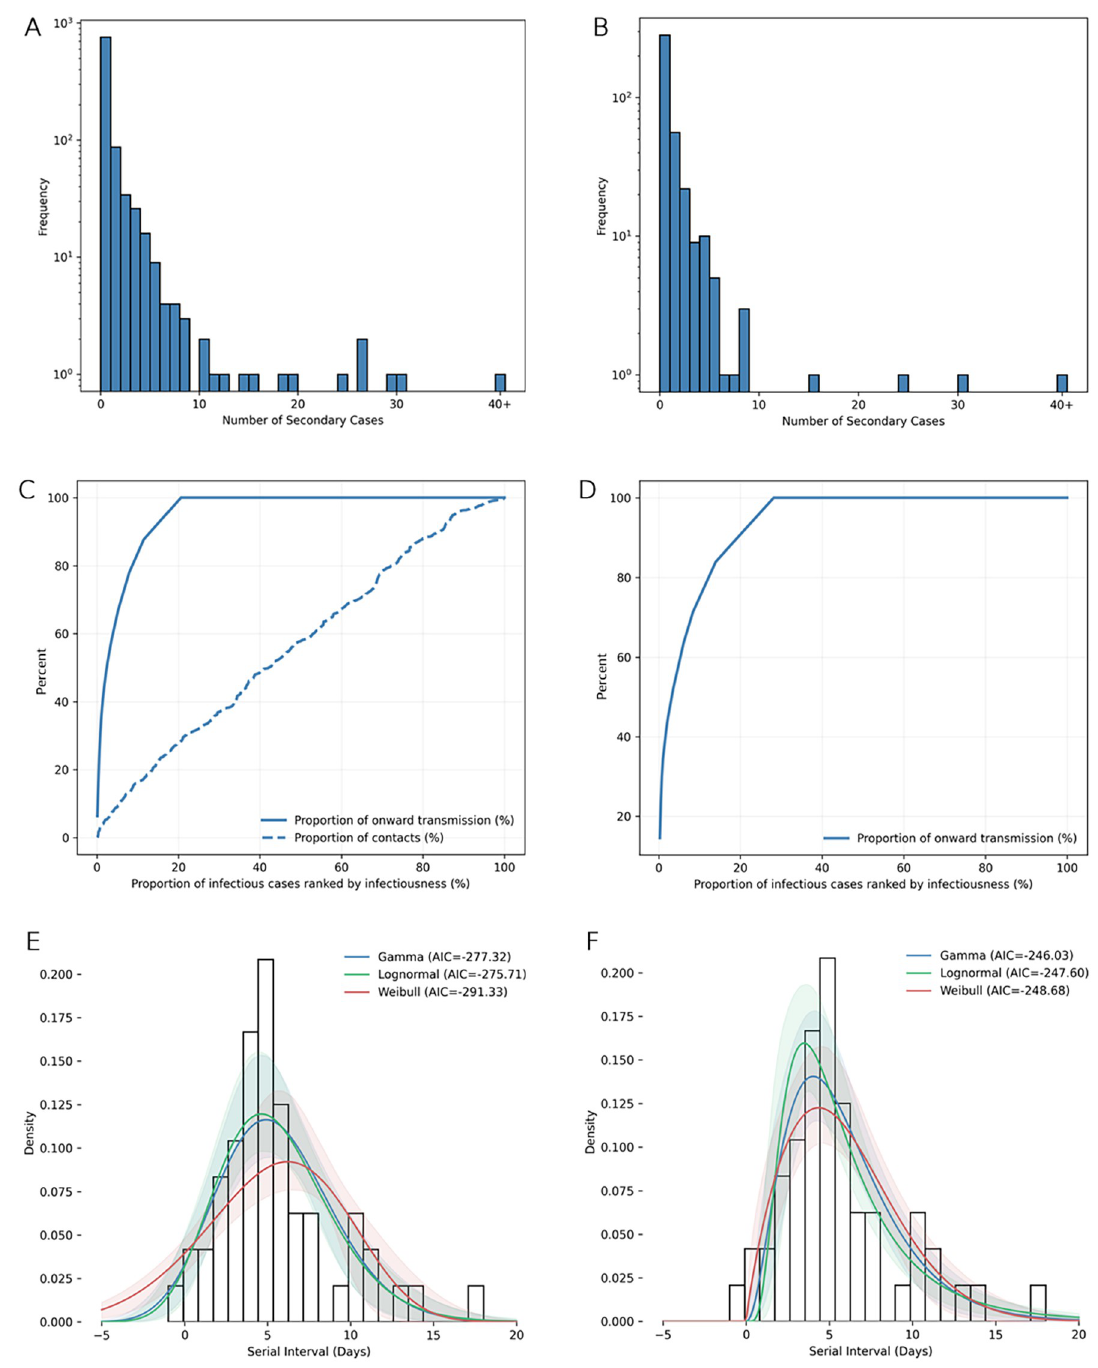
Fig 3. Transmission characteristics of SARS-CoV-2 in Karnataka, India. [A, B] Observed offspring distribution of [A] 956 cases with confirmed forward contact tracing and [B] 394 cases linked to the three largest clusters (Bellary cluster, Delhi convention cluster, and Pharmaceutical company cluster). Bars show observed frequency of the number of individuals infected by each case. [C, D] Proportion of all onward transmission (solid line) and proportion of all contacts (dashed line) due to a given proportion of infectious cases, where infectious cases are ranked by number of offspring cases (ie, infectiousness), for [C] 956 cases with confirmed forward contact tracing and [D] 394 cases linked to the three largest clusters. [E, F] Serial interval distribution of SARS-CoV-2 infections in Karnataka, India and the fitted gamma, lognormal and weibull distributions, among [E] 53 infector-infectee pairs and [F] 51 infector-infectee pairs with positive serial intervals. 10000 bootstraps were used for estimating the 95% confidence limits shown by the shaded bands.